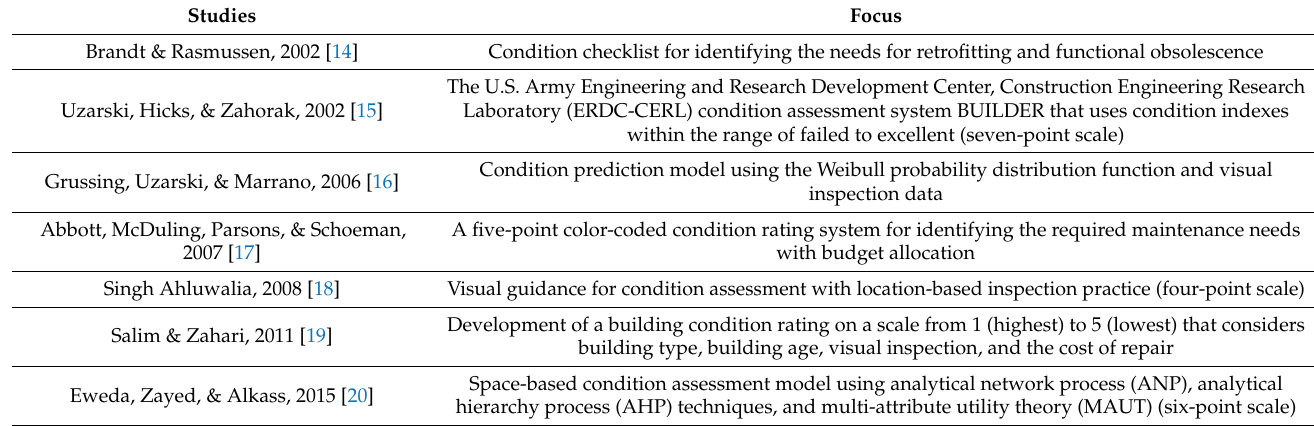
Table 1. Recent Studies in CA applied in FM